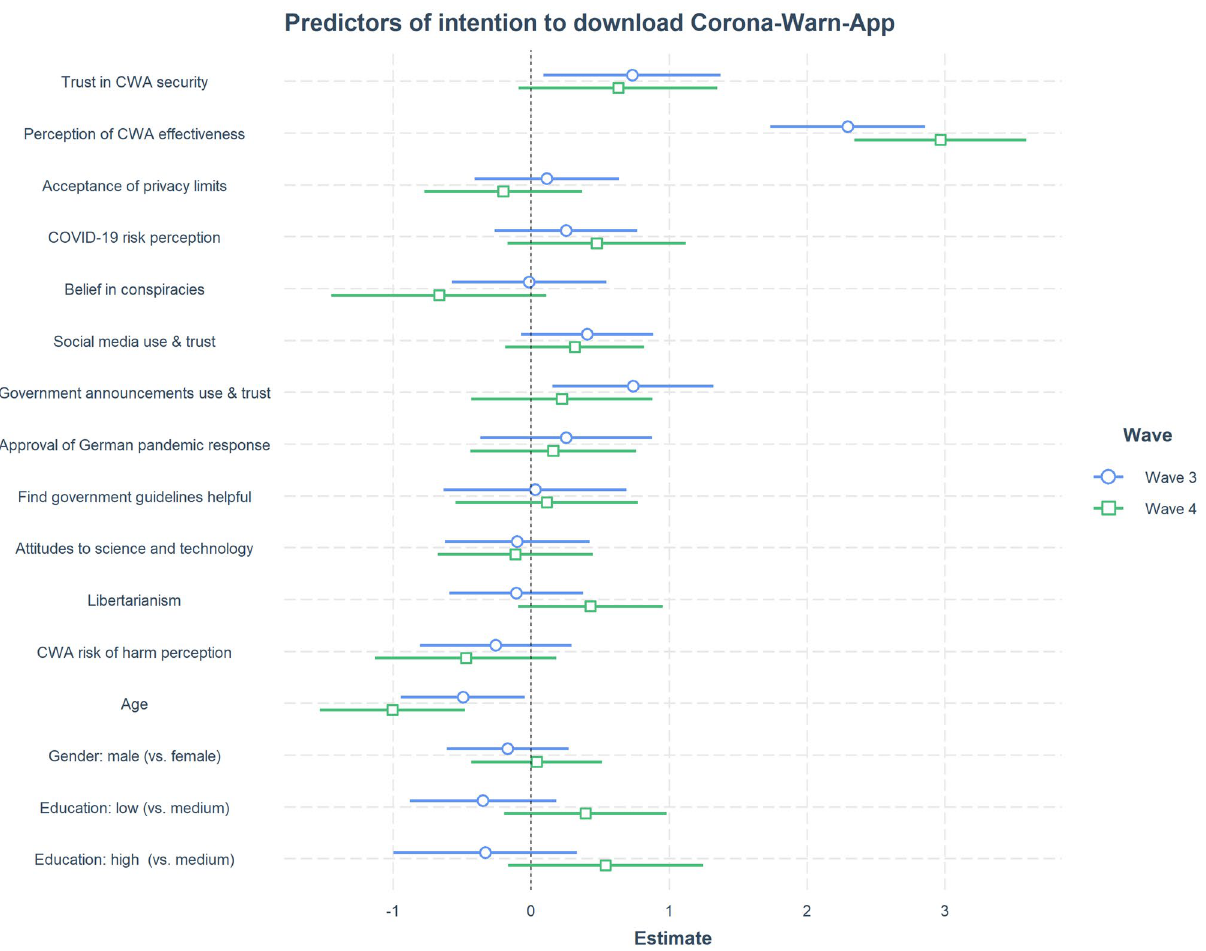
Figure 11. Logistic regression models for intention to download the Corona-Warn-App (Waves 3 and 4). Dependent variable: intention to download the app in the future (yes/no). Coefficients: measures from the survey (e.g., combined score for trust in app security; combined score for conspiracy beliefs; see Supplementary Table B10). Horizontal point ranges indicate point estimates and 95% confidence intervals for each predictor. Education was dummy coded with the reference level “medium,” yielding two coefficients: low (vs. medium) and high (vs. medium) education. Following 30 , we standardized all continuous variables by two standard deviations (SD) and mean centered the binary gender variable. This way a 2-SD change in a continuous predictor variable is approximately equivalent to a change of category in a roughly balanced binary predictor variable (e.g., gender). In a logistic regression model, a slope reflects the relative change in log odds (while keeping all other predictors at their average values). Supplementary Table A7 summarizes the regression results for both models. Supplementary Figure A9 provides an alternative arrangement of the same results, where the respective model for each wave is shown in a separate